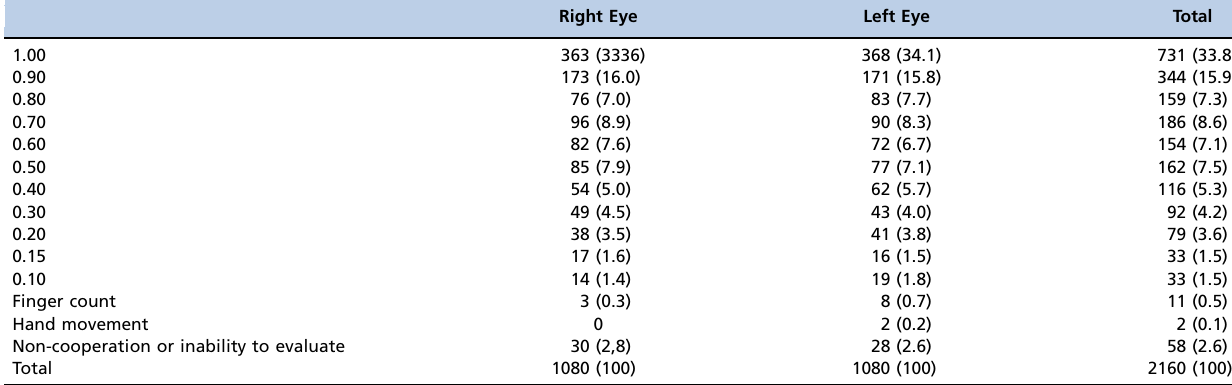
Table 1 - Distribution of Visual Acuity Without Correction*, n (%).